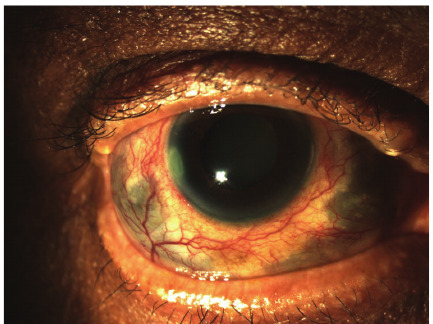
Figure 2: Anterior segment photograph of the right eye showing reduced conjunctival injection and increasingly prominent areas of scleromalacia following treatment with